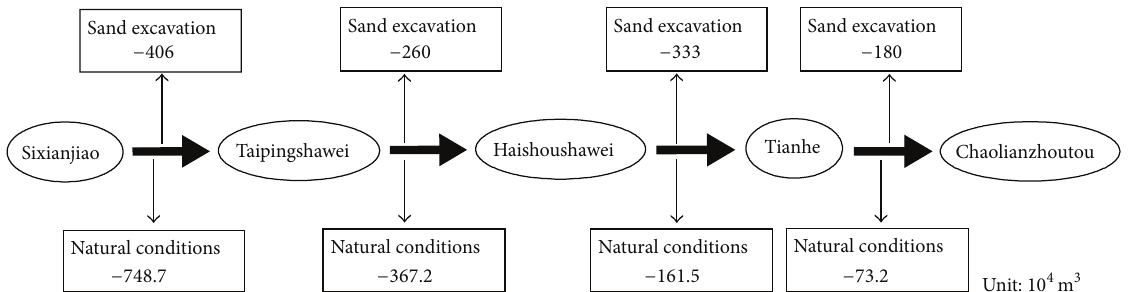
Figure 7: From Sixianjiao to Chaolianzhoutou, the annual amount of erosion and deposition in the sand excavation (up) and under the natural conditions (down) is provided in 1998. The comparison quantifies the impacts of the sand excavation in the bathymetry evolution and indicates that the amount of sand excavation has to be taken into account in the comparison between the observed and the modelled sediment erosion and deposition.